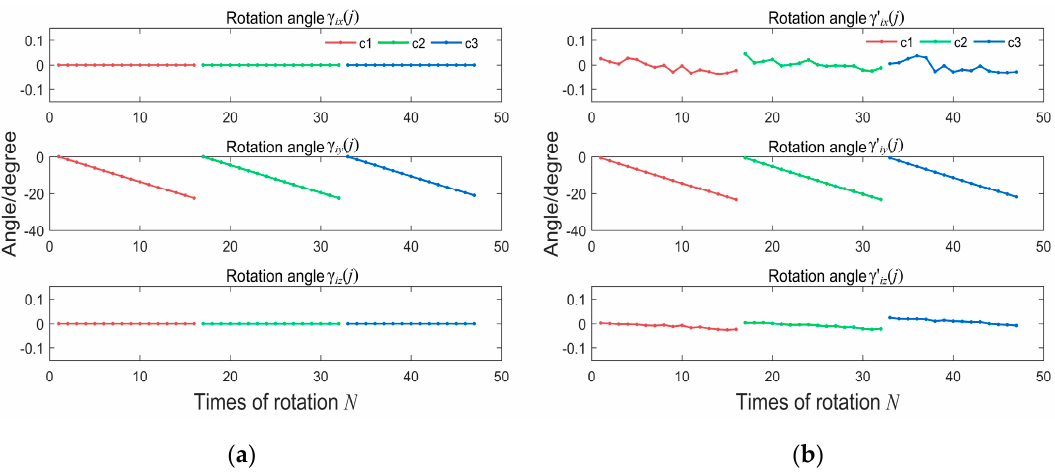
Figure 9. ( a ) Graph of the rotation angles γ ix ( j ), γ iy ( j ) and γ iz ( j ); ( b ) graph of the rectified rotation angles γ ' ix ( j ), γ ' iy ( j ) and γ ' iz ( j ).